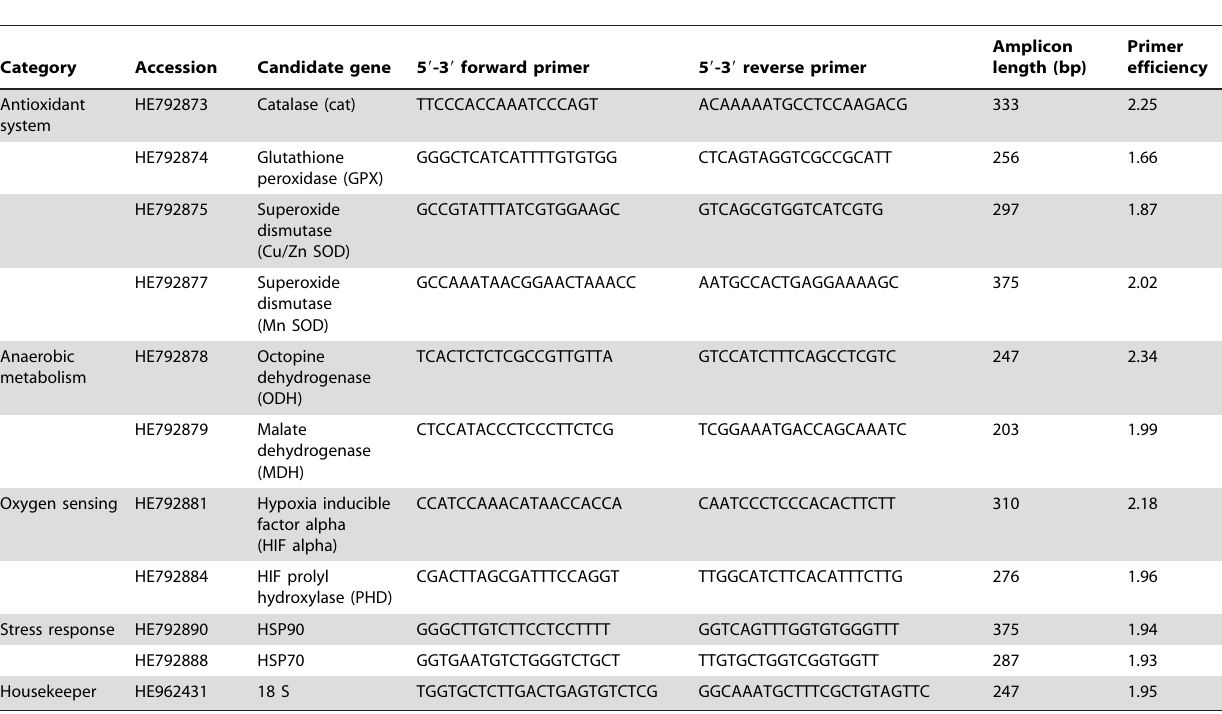
Table 1. Forward and reverse primer sequences used for quantitative real time PCR